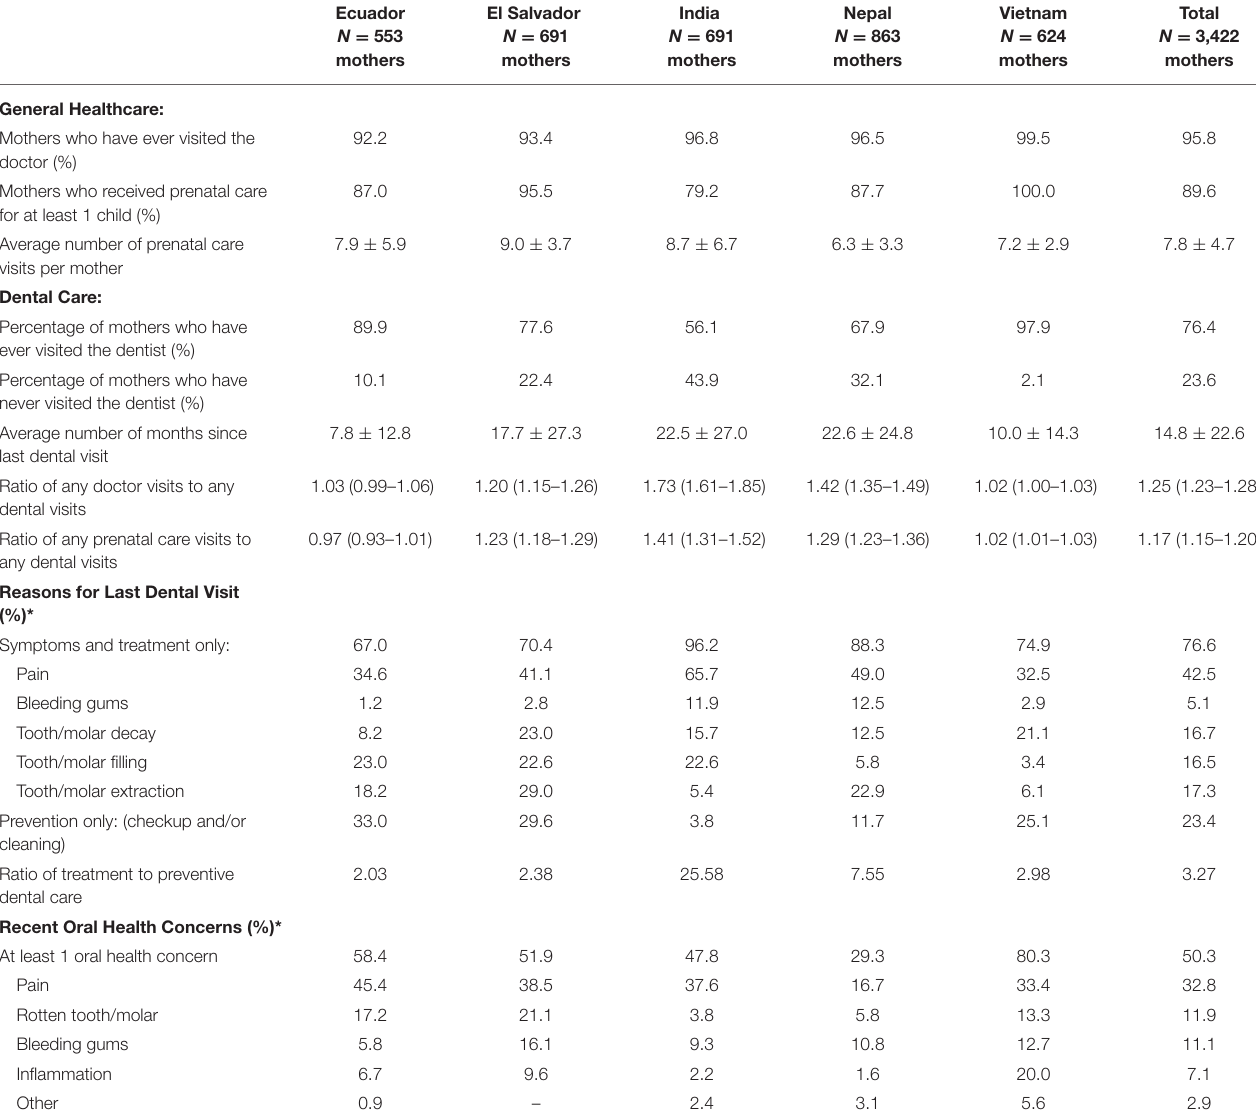
TABLE 2 | Mothers’ utilization of general healthcare and dental care.